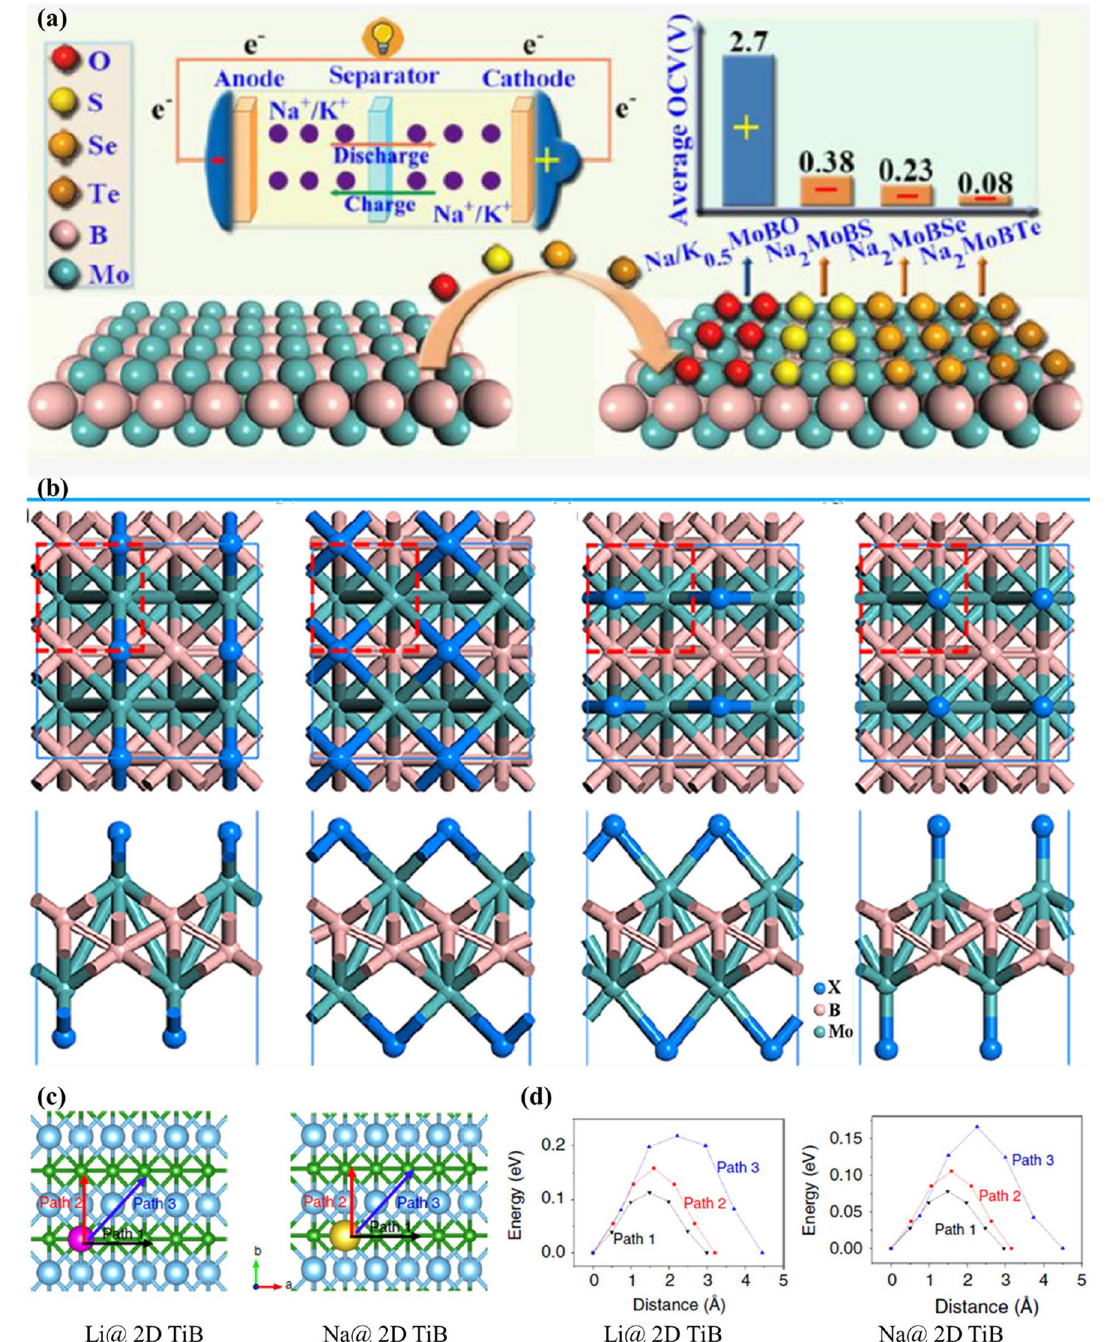
Fig. 19 a Schematic of a hybrid Na + /K + battery using MoBX (X=O, S, Se and Te) compounds as the electrode materials. Left: Average OCVs of Na 0.5 MoBO and K 0.5 MoBO for cathode application and of Na 2 MoBS, Na 2 MoBSe, and Na 2 MoBTe for anode application. Calculated evolu- tion of OCV values with different metal ion concentrations in Na x MoBO (middle) and K x MoBO (right). b Top and side views of adsorption sites for MoBX (X = O, S, Se, and Te). The unit cell is emphasized by a red dashed rectangle. The blue, pink, and ocean-blue balls represent X, B, and Mo atoms, respectively. Reproduced with permission from Ref. [241]. c Considered diffusion paths for Li and Na on the TiB monolayer. d Calculated diffusion energy barriers along the paths in c . The purple and yellow spheres represent Li and Na atoms, respectively. Reproduced with permission from Ref. [90]. (Color figure